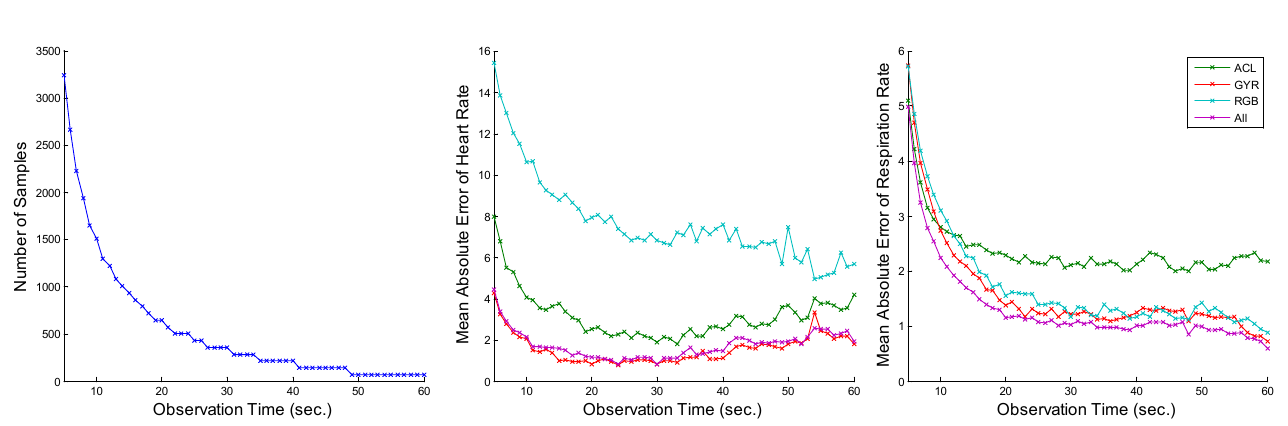
Figure 5 . Mean absolute error for heart (beats per minute) and respiration rates (breaths per minute) when considering different window sizes. (ACL: Accelerometer, GYR: Gyroscope, RGB: